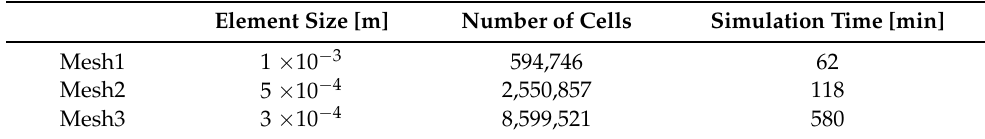
Table 1. Mesh parameters used for mesh independence tests.